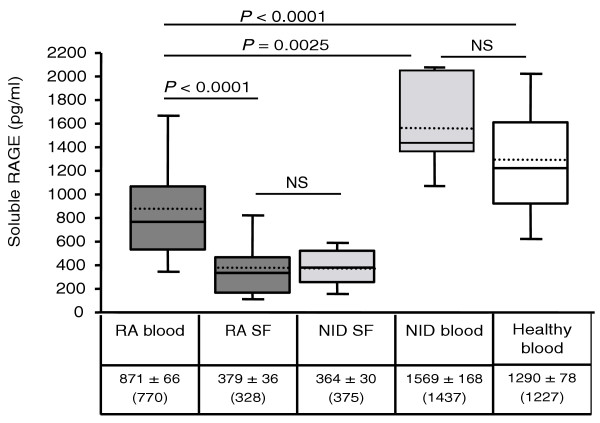
Levels of soluble receptor for advanced glycation end products (soluble RAGE) in blood and synovial fluid (SF) of rheumatoid arthritis (RA) patients and in patients with degenerative/traumatic joint diseases (non-inflammatory joint disease [NID]). In addition, blood levels of soluble RAGE were assessed in healthy controls. Box plots show the 25th and 75th percentiles. Horizontal lines in bold within boxes indicate medians, and dashed lines indicate means. Vertical bars indicate the 5th and 95th percentiles. Statistical differences with respect to soluble RAGE levels between groups were calculated using the Mann–Whitney U test, and differences between paired samples were calculated by the Wilcoxon signed rank test. Mean ± standard error of the mean (median) values are shown. NS, not significant.